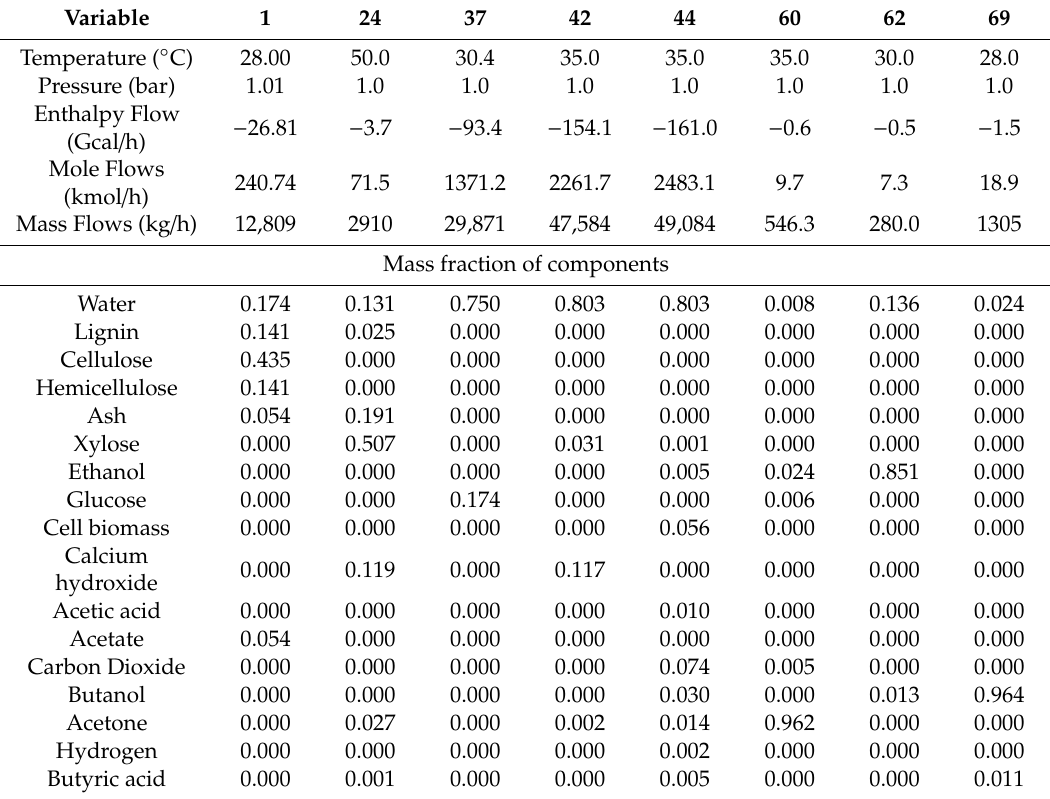
Table 4. Process data of the main streams for topology 1.